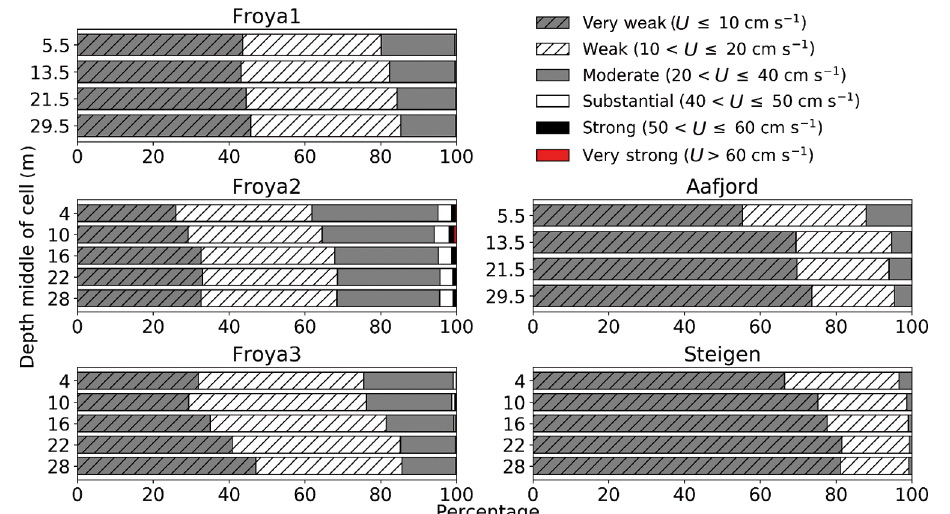
Fig. 4. Total distribution of current classes over the entire duration of deployment for selected depths at each location. U : current speed. See Fig. 1 for site locations